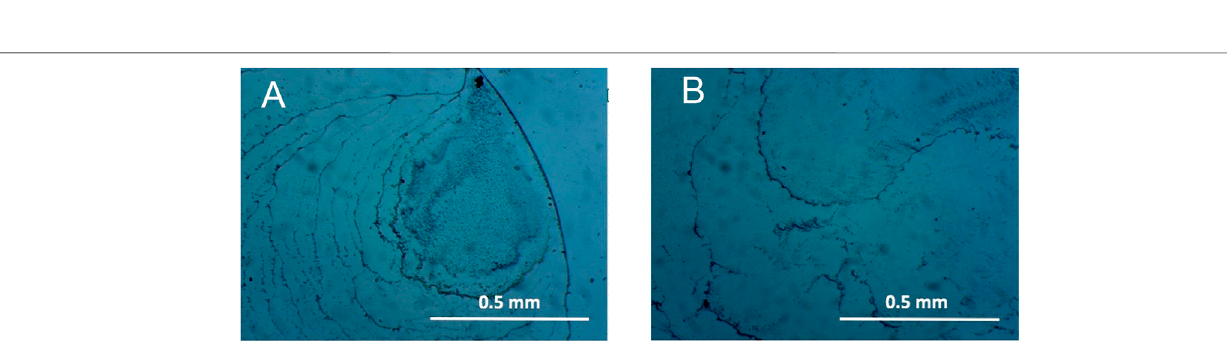
Frontiers in Physics |